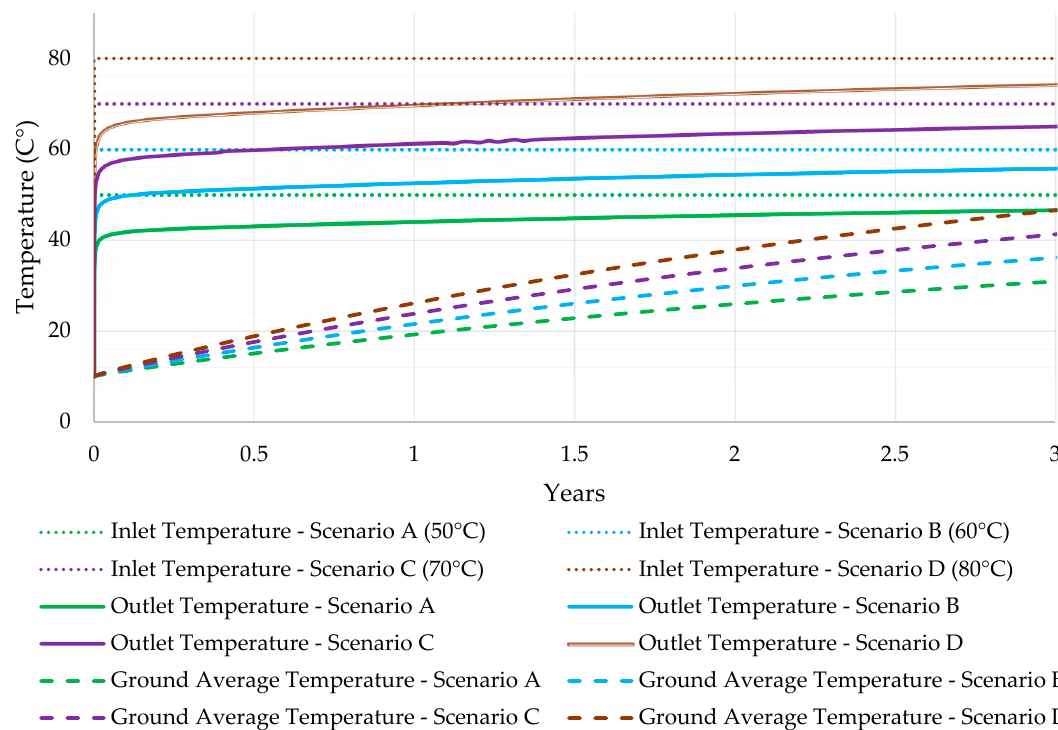
Figure 5. Ground Temperatures of inlet and outlet water and average ground temperature during the ground pre-conditioning period.